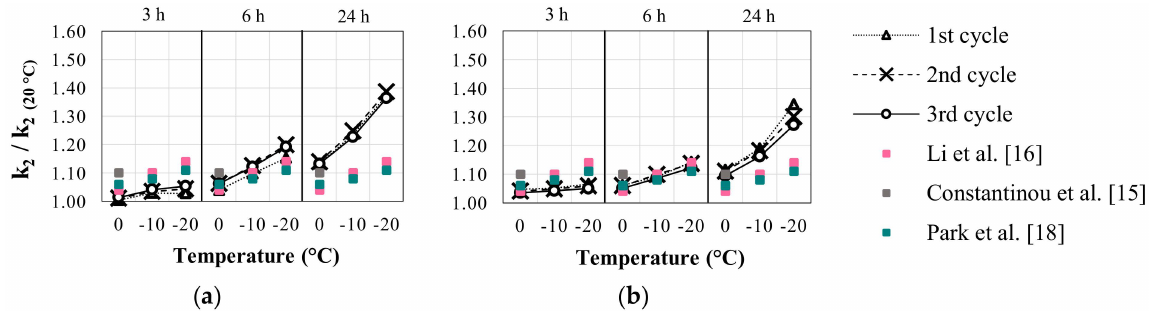
Figure 17. Comparison of amplifications in k 2 with the estimations of amplification factors in the literature for 0.1 Hz loading frequency at ( a ) 100% and ( b ) 134% shear